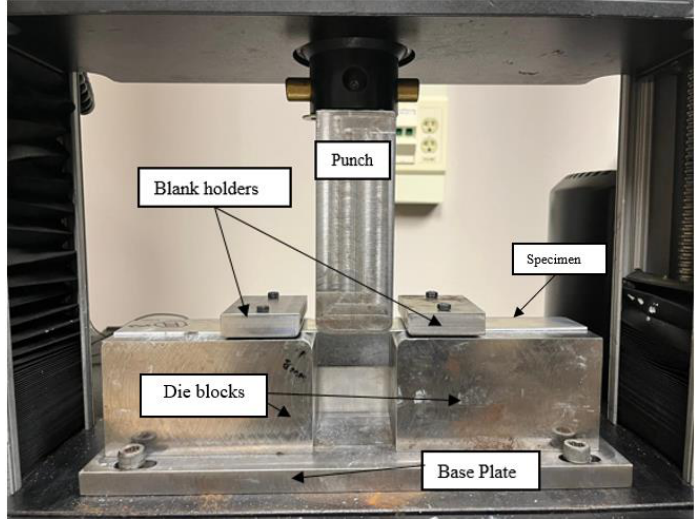
Figure 24. Experimental draw bending tool setup installed on an Instron testing machine.